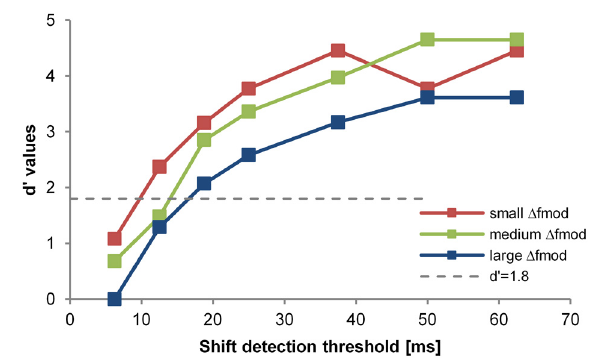
FIGURE 2 | Psychometric function of one subject for one stimulus condition (i.e., exp. 2, f c = 4kHz). The d (cid:4) -value is plotted in relation to the shift of the B-signal in ms (x-axes). The differently colored lines and symbols show the different (cid:2) f mod conditions tested (see legend).The threshold criterion of d (cid:4) = 1 . 8 is indicated by the dotted gray line. The shift detection threshold ( d (cid:4) = 1 . 8) was interpolated between data points lying above and below that d (cid:4) -value. The slight differences in largest d (cid:4) values are due to different false alarm rates for the different (cid:2) f mod conditions.